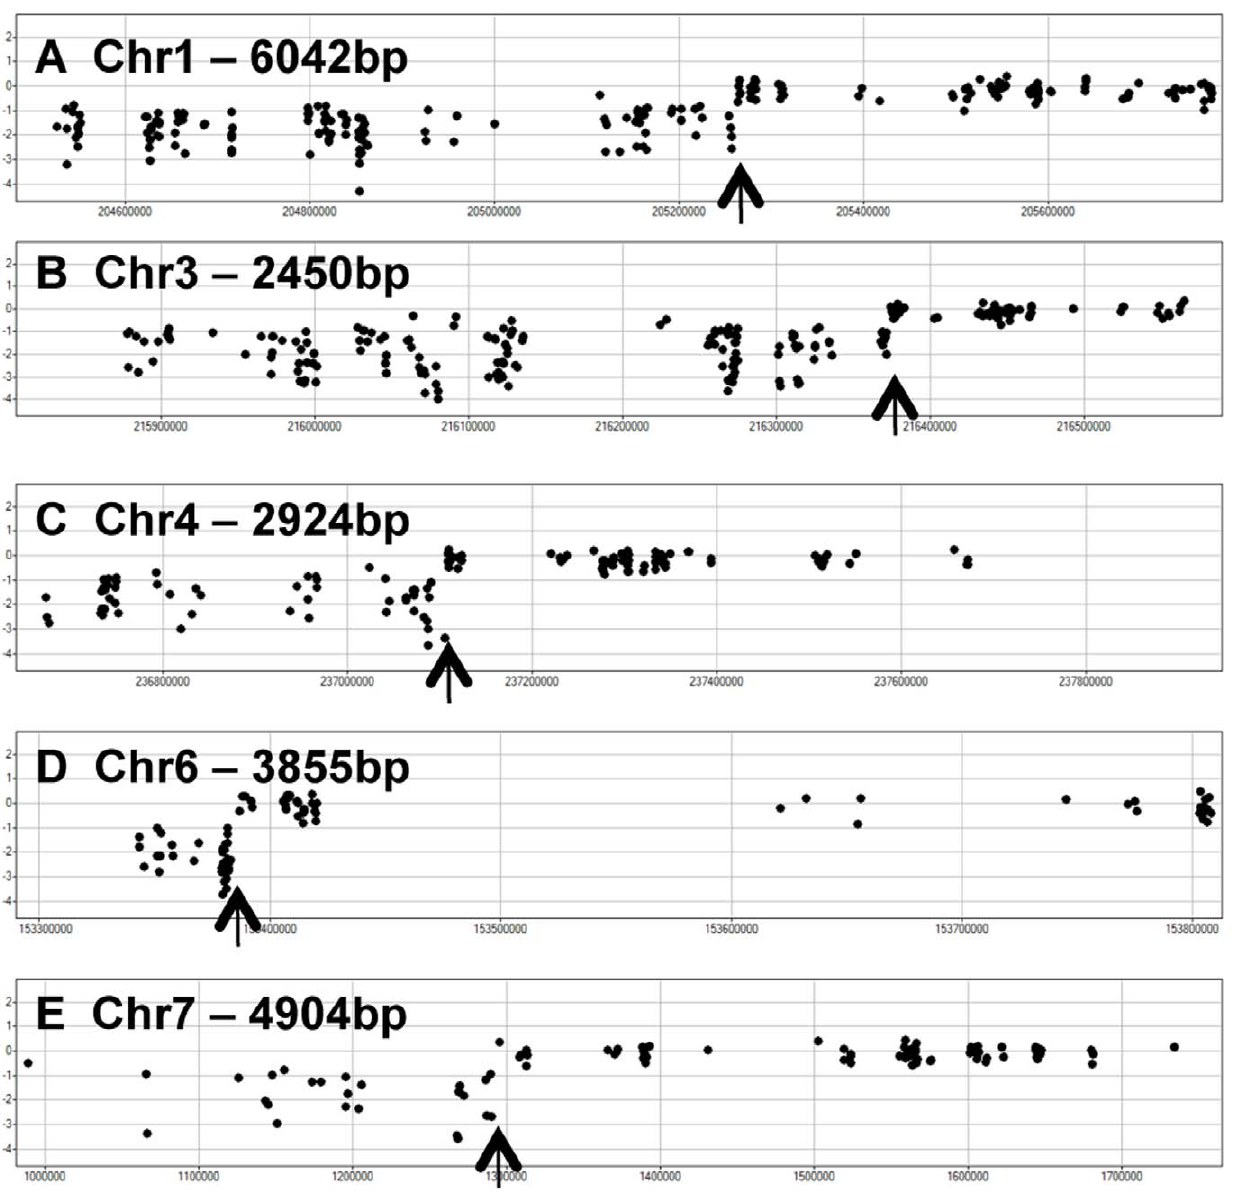
Figure 3. High-resolution of recombination break-points. Several plots show detailed views of the CGH mapping data near recombination events in the RIL M0022. The log2(M0022/B73) value is plotted along the y-axis for each of the B . M probes (q , 0.0001 and fold-change . 2) in five genomic regions. The arrowheads indicate the position of the recombination event and the label indicates the chromosome and the base pair resolution of the recombination event.